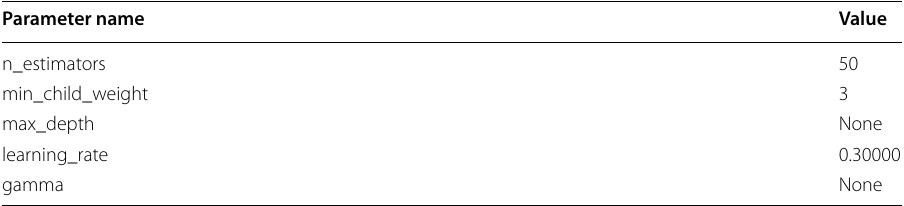
Table 87 Modes of XGBoost tuned hyperparameter values for experiments with the data exfiltration